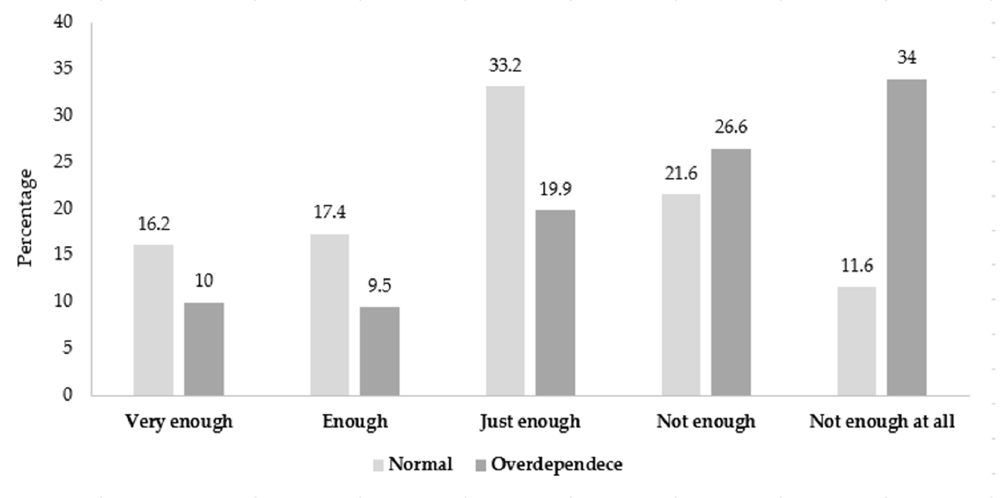
ence group, respectively.